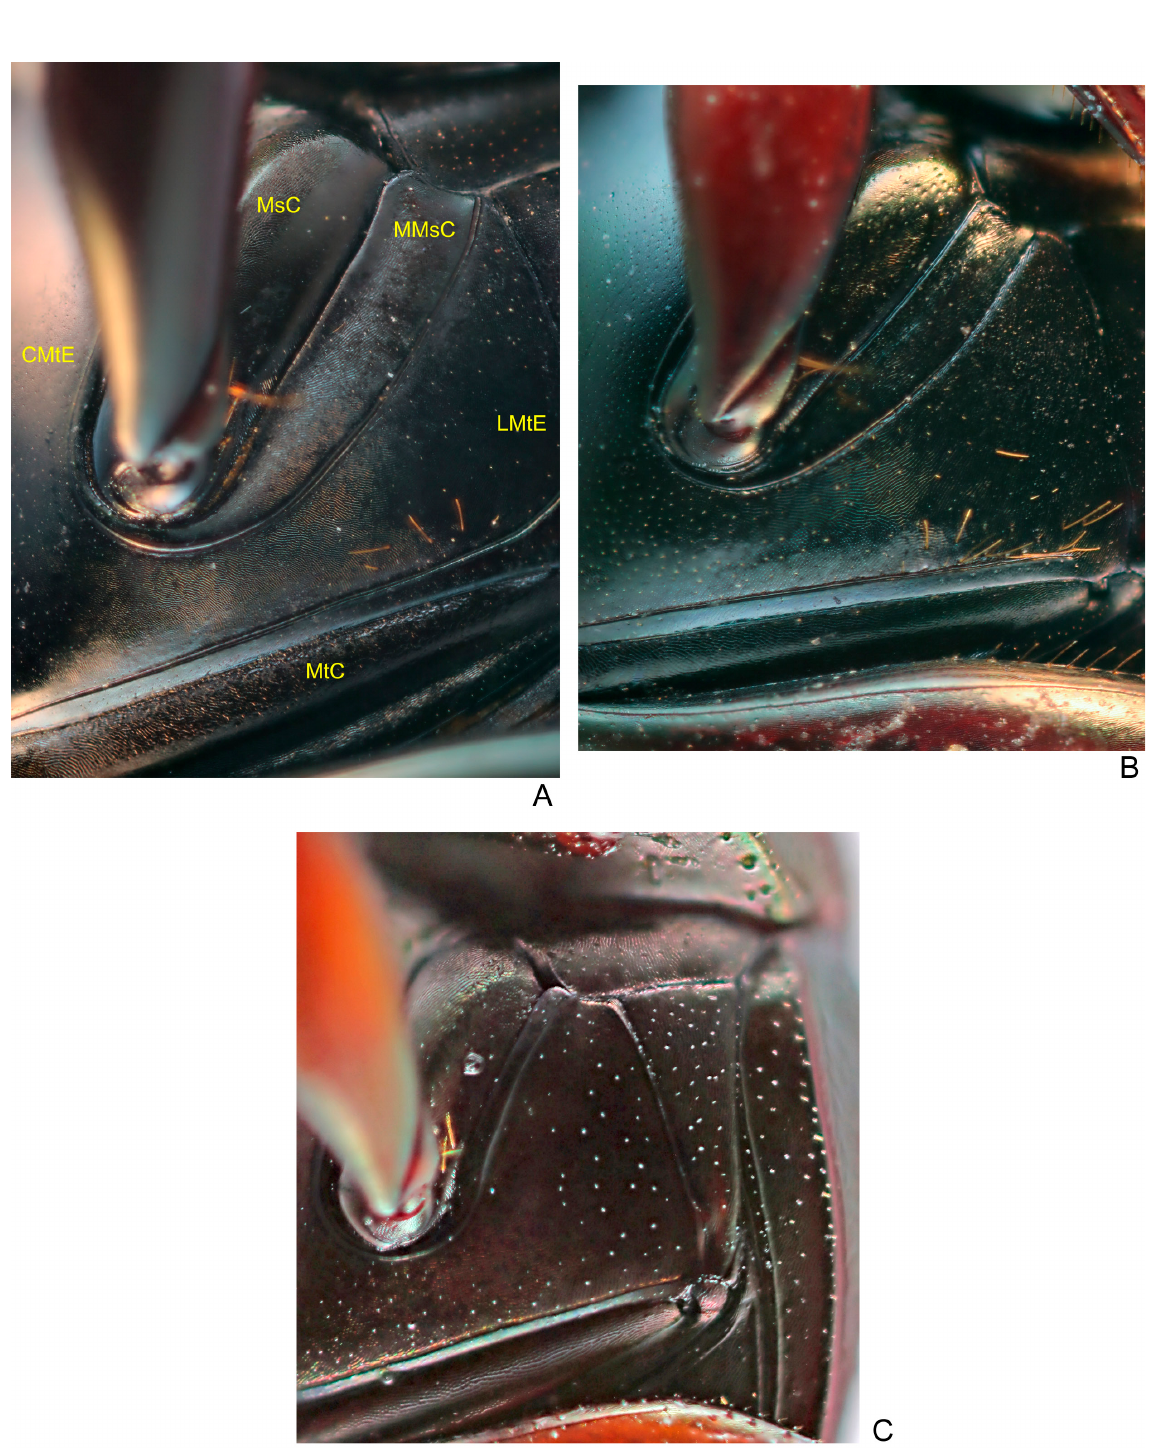
Fig. 7. Pterothorax, ventrolateral views. A . Sylvicanthon aequinoctialis (Harold, 1868) comb. nov. B . S. obscurus (Schmidt, 1920). C . Canthon xanthopus Blanchard, 1846. Abbreviations: MsC = mesocoxa; MMsC = external margin of mesocoxa; CMtE = centre of metaventrite; LMtE = lateral region of metaventrite; MtC =